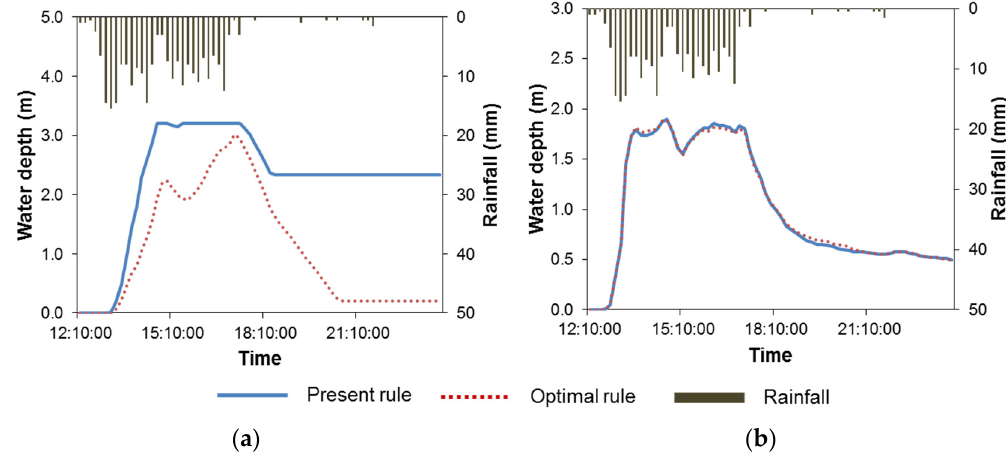
Figure 7 . Comparison of current and optimal detention reservoir facilities in terms of water depth at: ( a ) detention storage unit and ( b ) control node in September 2010. Table 3. Comparison of present and optimal detention reservoir facilities according to flood damages in 2010.